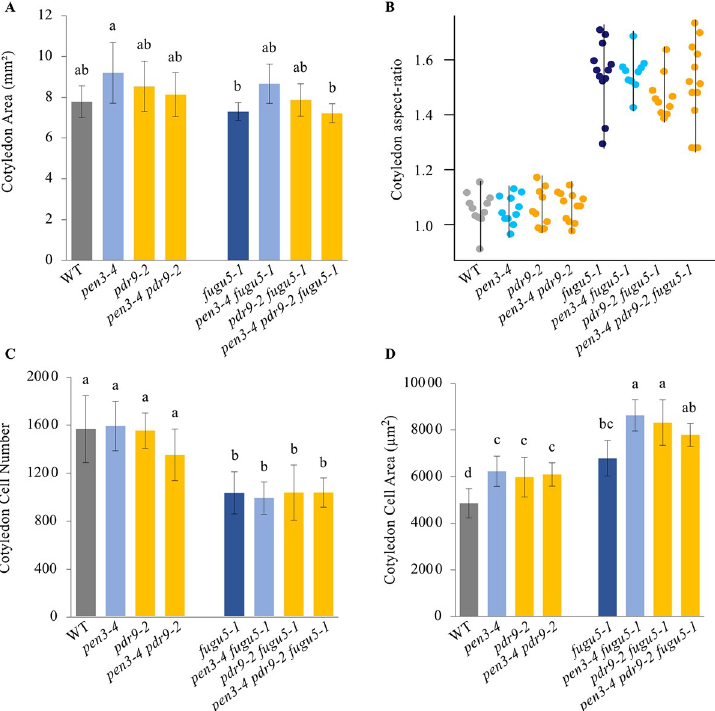
Fig 3. pen3–4 and pdr9–2 Mutations Independently and Collectively Enhanced Compensated Cell Enlargement in fugu5 . Cotyledons were dissected from plants grown on rockwool for 25 DAS, fixed in FAA, and cleared for microscopic observations. Data show the cotyledon area (A) , cotyledon aspect-ratio (B) , cotyledon cell number (C) and cotyledon cell area (D) , respectively. Data are means ± SD (n = 8 cotyledons). The cotyledon aspect ratio was calculated by dividing cotyledon blade length by cotyledon blade width. Longer cotyledons have greater aspect-ratio values. Data in the beeswarm plots indicate the value of aspect-ratio (n ≦ 10 cotyledons). Letters indicate groups (Tukey’s HSD test at P < 0.05; R version 3.5.1). DAS, days after sowing.